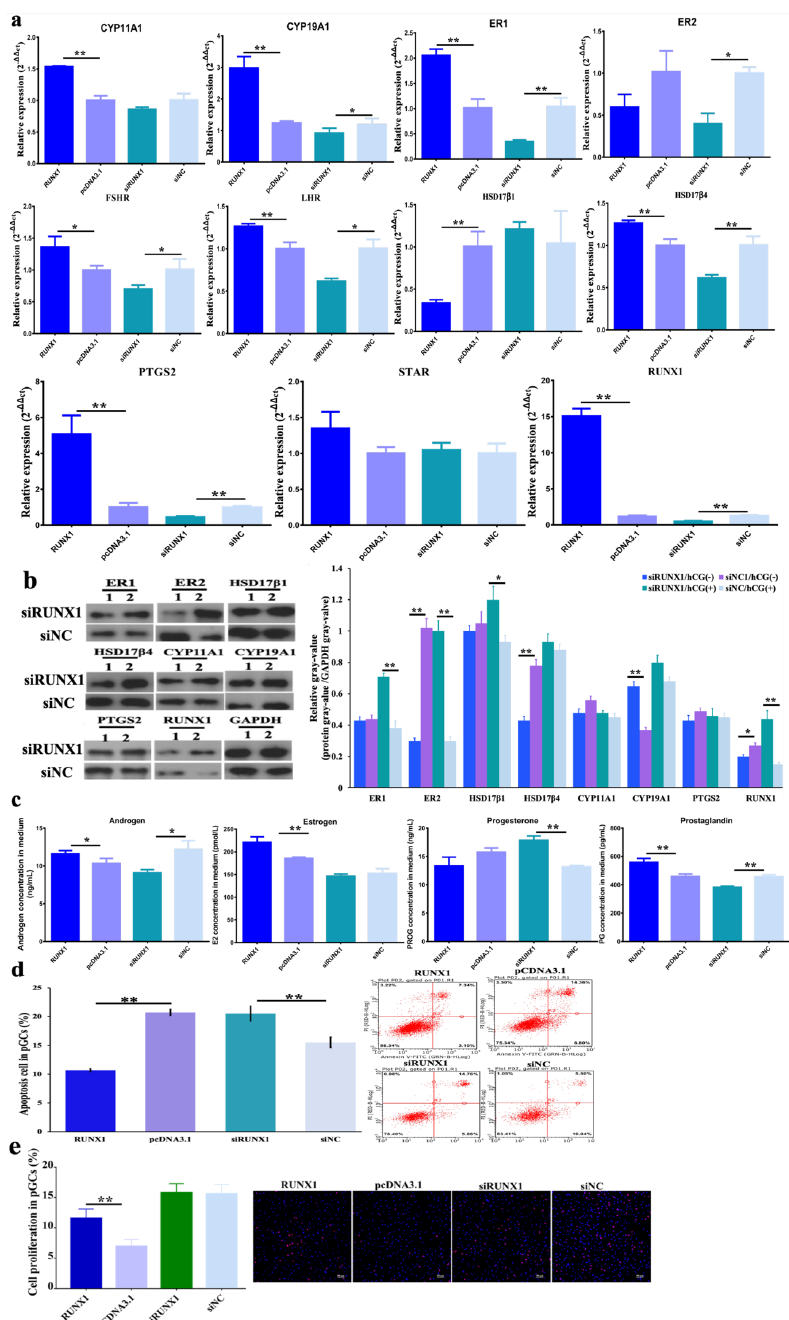
Figure 5. The influence of RUNX1 on steroidogenesis, cell apoptosis and proliferation in pGCs. ( a ) The expression pattern of steroidogenesis related genes when RUNX1 was overexpressed or knocked down. The * indicates p < 0.05 and ** indicates p < 0.01. ( b ) Protein translation of RUNX1, PTGS2, ER1, ER2, HSD17 β 1, HSD17 β 4, CYP11A1, and CYP19A1 when pGCs were with / without human chorionic gonadotropin (hCG) in the situation of siRUNX1 or siNC. The numbers 1 and 2 indicate that pGCs were treated without / with hCG. ( c ) The hormone synthesis of androgen, estrogen, prostaglandin, and progesterone in the situation of upregulation and knockdown of RUNX1 in pGCs. ( d ) The e ff ect of RUNX1 on pGC apoptosis. The pGCs apoptotic proportion in that column plot is a visualization from the sum of the upper and lower right quadrants in the scatter plot. ( e ) The e ff ect of RUNX1 on pGC proliferation. The proportion of proliferated cells in the column equal to the ratio of the numbers of proliferated cells to total